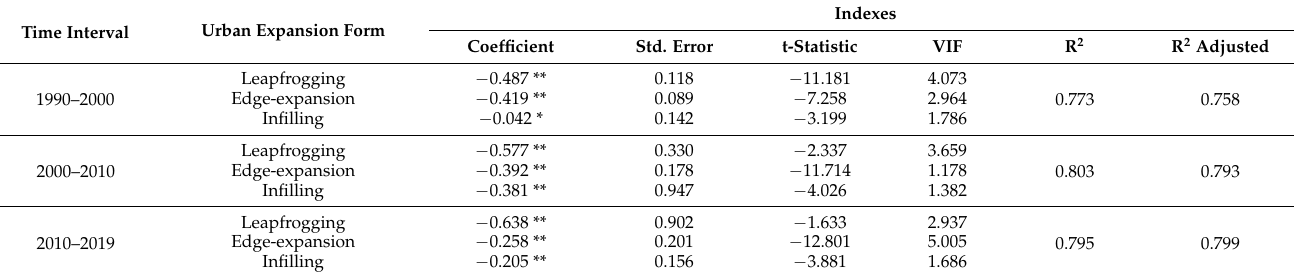
Table 9. The variance analysis results of the MLR model for the expansion intensity of urban expansion forms and the change in SR in different time